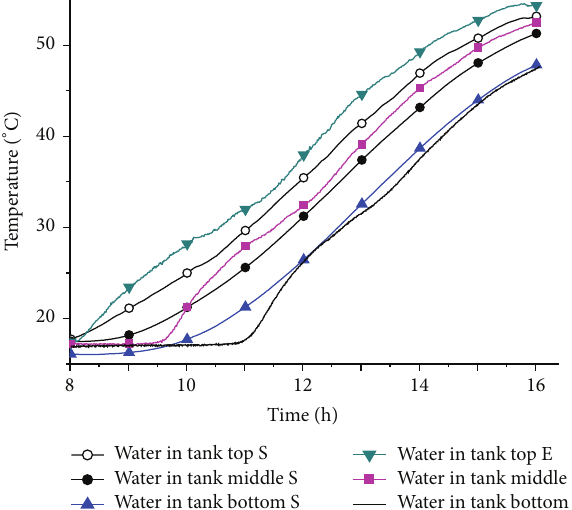
Figure 7: Variation of the temperatures in the collector with time (E: experimental results; S: numerical results).